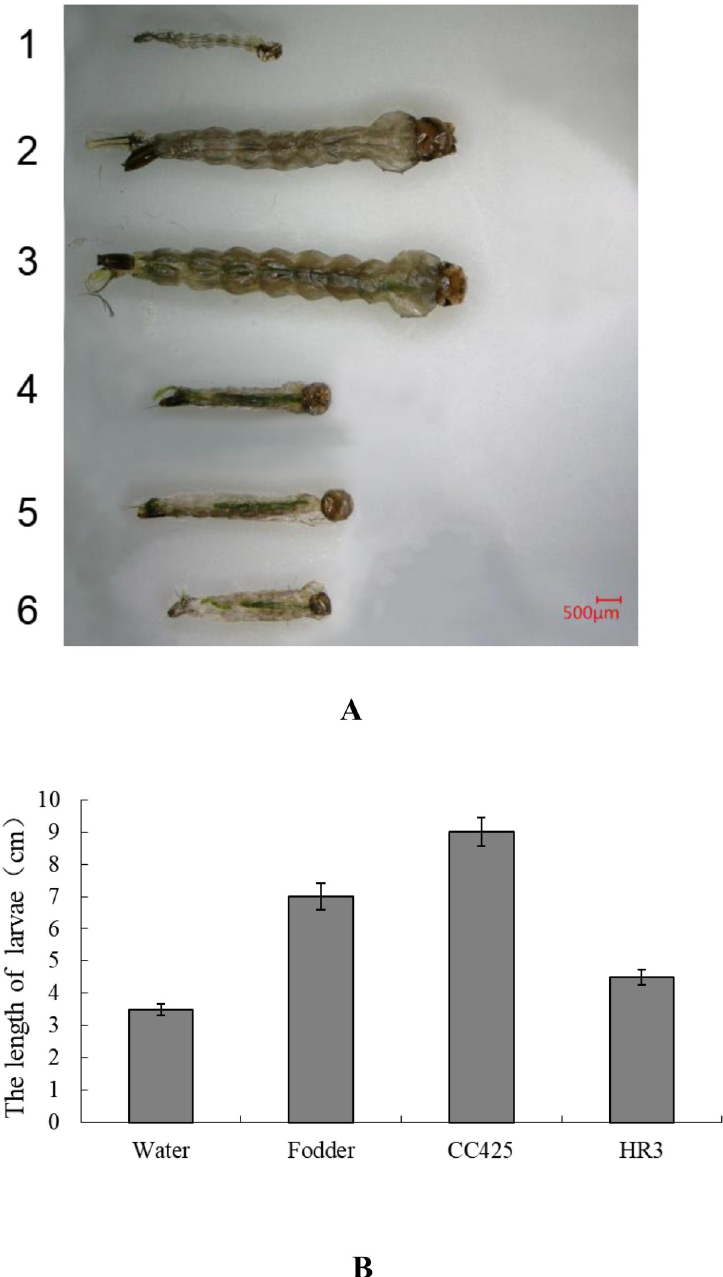
Fig 4. The length of Aedes aegypti larvae fed different foods. A: Observation of the size of larvae under an optical microscope. of them, 1, water: Aedes larvae fed with water; 2, fodder: Aedes larvae fed with fodder; 3,CC425: Aedes larvae fed with non-transgenic C. reinharditii strain CC425, 4, HR3: Aedes larva fed with pMaa7IR/HR3IR transgenic algae strain HR3-C9. B: the data of the body length of Aedes larvae fed with different food. length compared with the larvae fed with C . reinhardtii CC425. These results indicate that feeding the larvae with the HR3 RNAi transgenic algal strain largely affected their growth. Under the same feeding conditions, compared with control groups (fed with water, fodder, and C . reinhardtii CC425), the larvae fed with pMaa7IR/HR3IR transgenic algae died as early